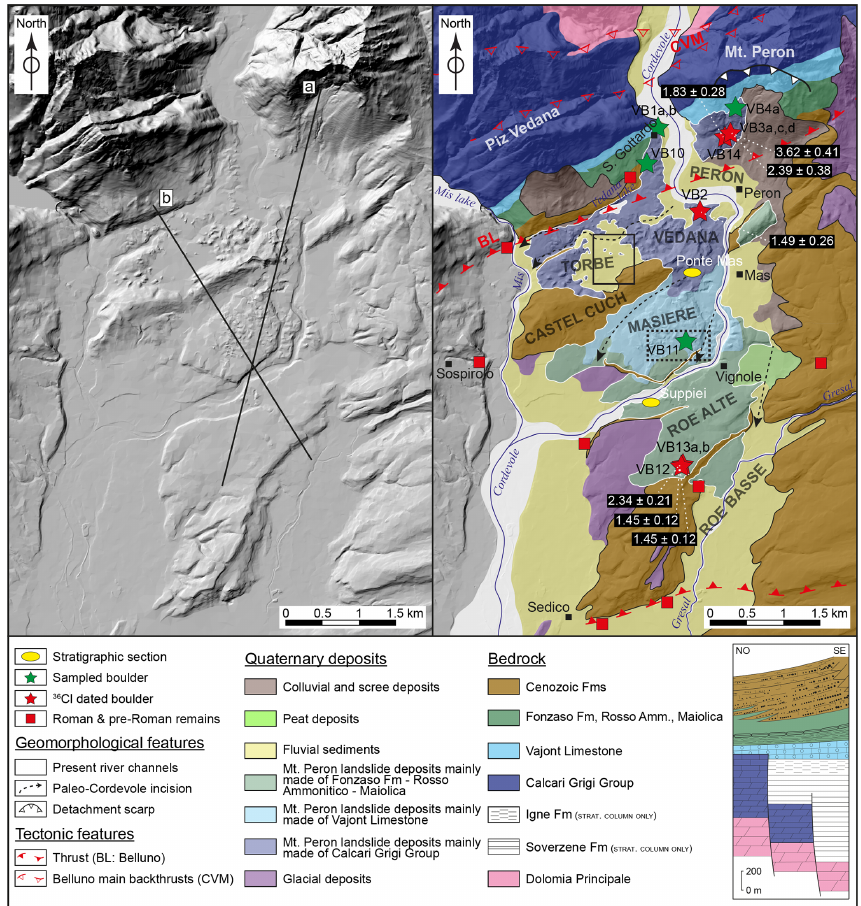
Figure 3. Geological map of the study area, based on our own field surveys and previous studies (Pellegrini, 2000; Pellegrini and Caneve, 2005), overlying a 5m cell DTM (open data released by Regione Veneto: http://idt.regione.veneto.it/app/metacatalog/, last access: 17 Oc- tober 2019). The boundary of Mt. Peron rock avalanche deposits is marked with a solid white line, whilst the contact between Quaternary sediments and bedrock is shown with a solid black line. The locations of boulders sampled for dating (red stars) and/or thin-section analysis (green stars) are shown. Obtained 36 Cl exposure ages are in kiloannum. Sites of Roman and pre-Roman archeological findings are indicated by red squares (from Capuis et al., 1988). Solid lines in the left frame correspond to the traces of the stratigraphic profiles in Fig. 4. Location of stratigraphic sections (yellow ellipses; Fig. 5) and palaeo-Cordevole paths (black dashed arrows) are shown. The extent of Fig. 6 (dotted black box) and Fig. S4 (solid black box; Supplement) is indicated. In the lower right, a stratigraphic sketch of bedrock formations cropping out in the Belluno area is given (modified from Costa et al.,